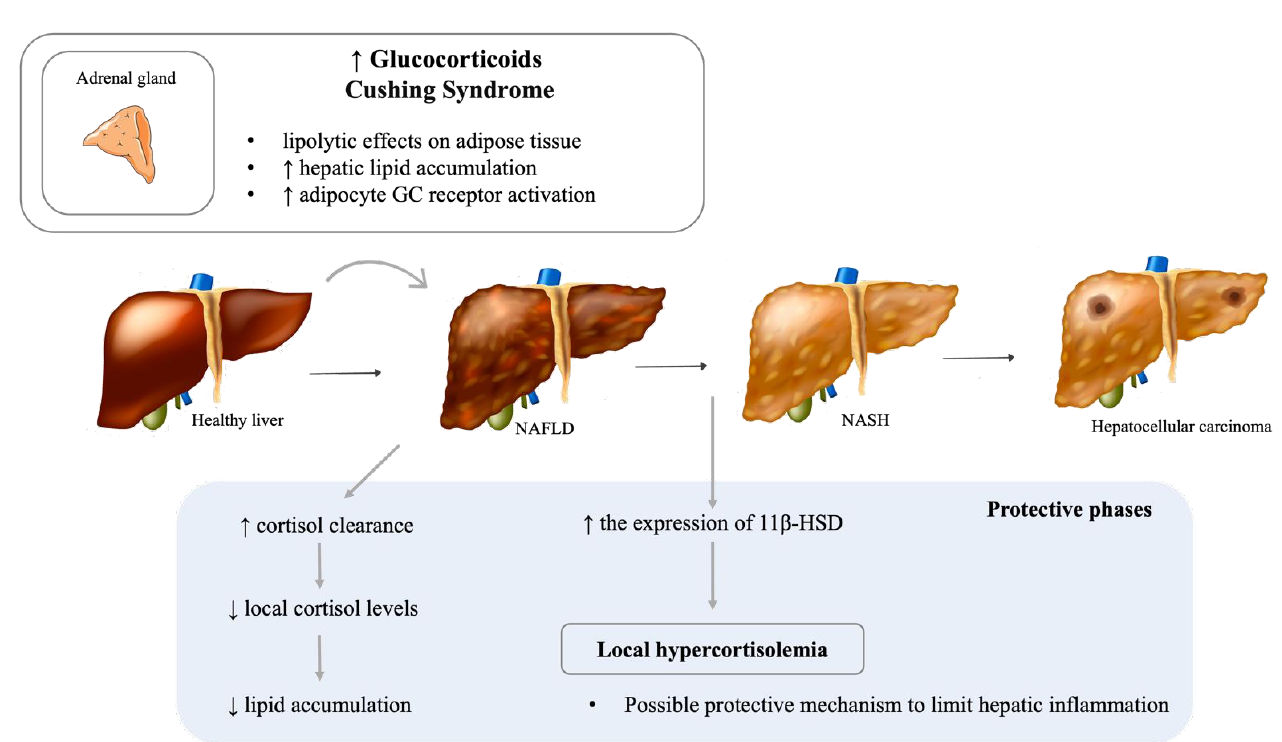
Figure 5. Impact of cortisol imbalance and NAFLD pathogenesis. NAFLD: Nonalcoholic fatty liver disease; NASH: Nonalcoholic steatohepatitis. [Viktoriia Kasyanyuk] © 123RF.com (accessed on 22 February 2022) and Servier Medical Art by Servier.